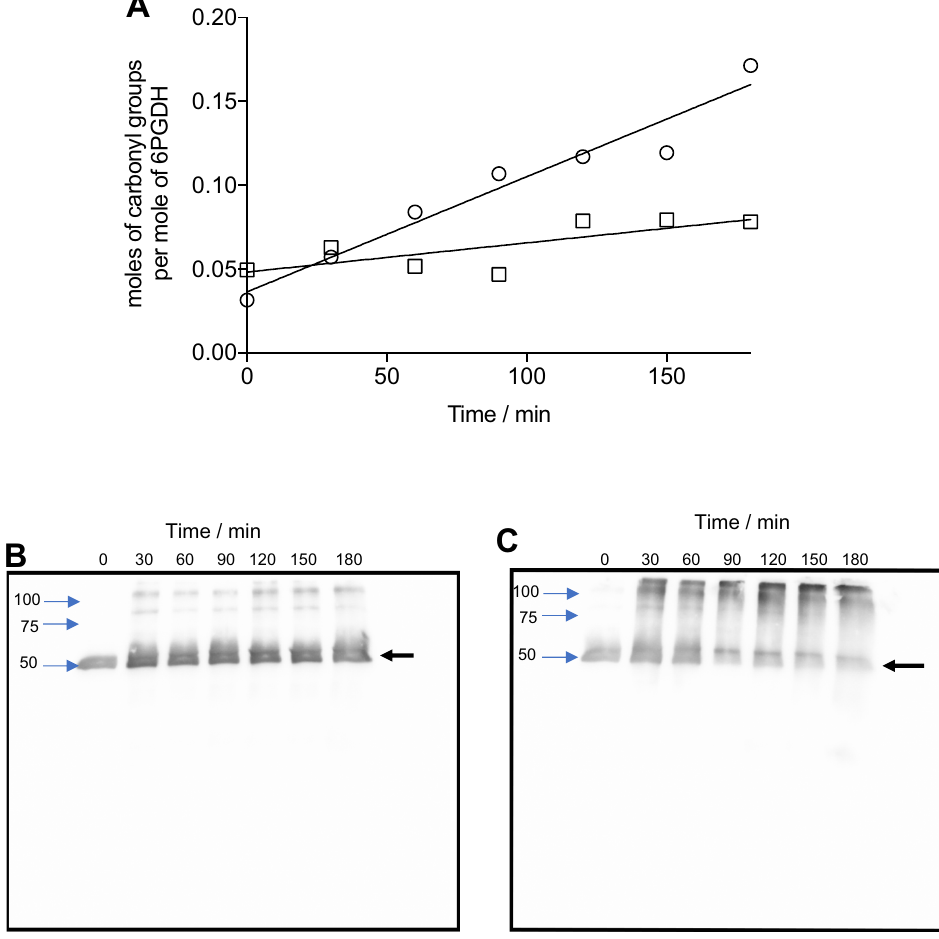
Figure 5. Detection and quantification of carbonyl groups on AAPH-treated 6PGDH samples. Solutions containing 6PGDH (58 μM monomer) with or without 10 or 100 mM AAPH were incubated at 37 °C in 75 mM phosphate buffer at pH 7.4. Aliquots were taken every 30 min up to 180 min, the AAPH was then removed, and samples kept at -80 ºC until analysis. Panel ( A ): quantification of the total carbonyl content on 6PGDH determined by DNPH assay incubated in the presence of 10 (open square) and 100 (open circle) mM AAPH. Panels ( B ) and ( C ): carbonyls detected by western blotting (using a commercial Oxyblot system) for samples exposed to 10 or 100 mM AAPH, respectively. On right vertical axis, black arrows indicate the band corresponding to 6PGDH monomers, while on left vertical axis, blue arrows indicate the corresponding molecular masses (obtained by comparison with molecular mass markers). For panels ( B ) and ( C ), it should be noted that images correspond to cropped and aligned WB images of membranes exposed for 50 s (as presented in Fig.S11). The data presented in panel ( A ) are the mean of at least three independent experiments, each developed in